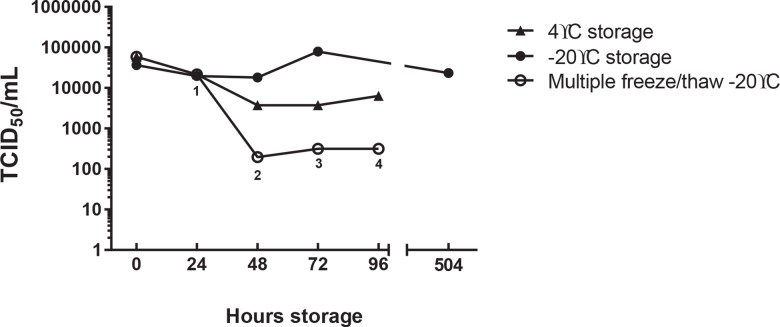
The effect of low temperatures on HCMV viability.Pasteurized breast milk was spiked with AD169 stock 1:5 and 0.5 mL aliquots were prepared and either stored at 4°C or frozen at -20°C. After 24, 48, 72 and 96 hours at 4°C or -20°C, samples were removed/thawed and analysed by TCID50 on human foreskin fibroblasts (HFF). One sample was stored at -20°C for 21 days (504 hours). The presence or absence of CPE was determined for each well and calculated using the Reed and Muench Calculator. Results are presented as TCID50/mL. Superscripts (1–4) underneath multiple freeze/thaw samples designate the number of times the sample was thawed.